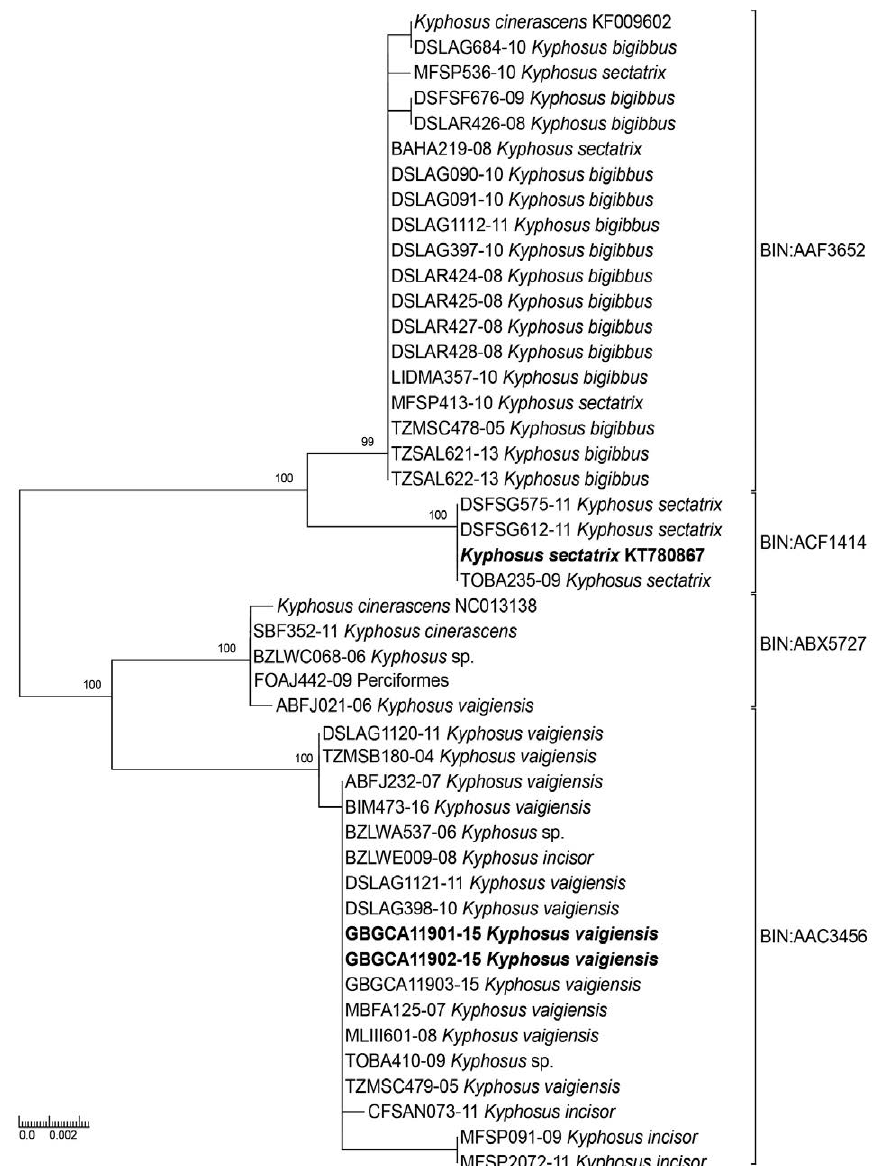
Fig. 2. – Neighbour-joining tree of Kyphosus COI sequences. Numbers by the nodes indicate bootstrap supports. Sequences from European Atlantic waters of Galicia specimens are in bold letters. BIN: Barcode Index pelagic, associated with flotsam, and can be encoun- tered in the open ocean. Widely distributed in the west Pacific, to at least the Revillagigedo Islands, the east Pacific, the Indian Ocean, the Red Sea, the Atlantic and the Mediterranean (Knudsen and Clements 2013).